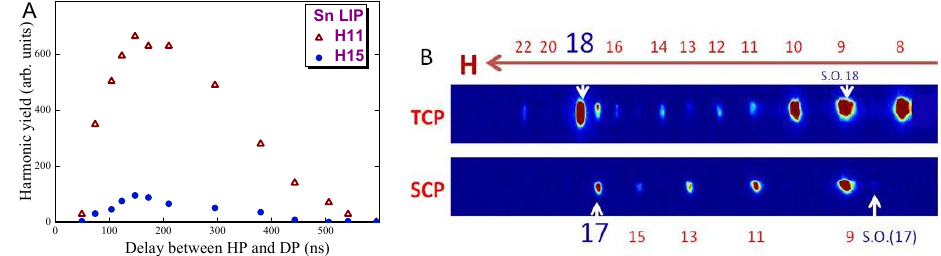
Figure 3. ( A ) Variations of the 11th (open triangles) and 15th (filled circles) harmonic yields at different delays between the heating and driving pulses. The fluence of heating pulses on the tin surface was 1.5 J cm − 2 . ( B ) Raw images of harmonics in the case of a two-color pump (TCP; 806 nm and 403 nm, upper panel) and a single-color pump (SCP; 806 nm, bottom panel) of tin plasma. Arrows show the maximally enhanced harmonics and their second-order (S.O.) diffractions from the flat-field grating in the case of the two types of pumps.